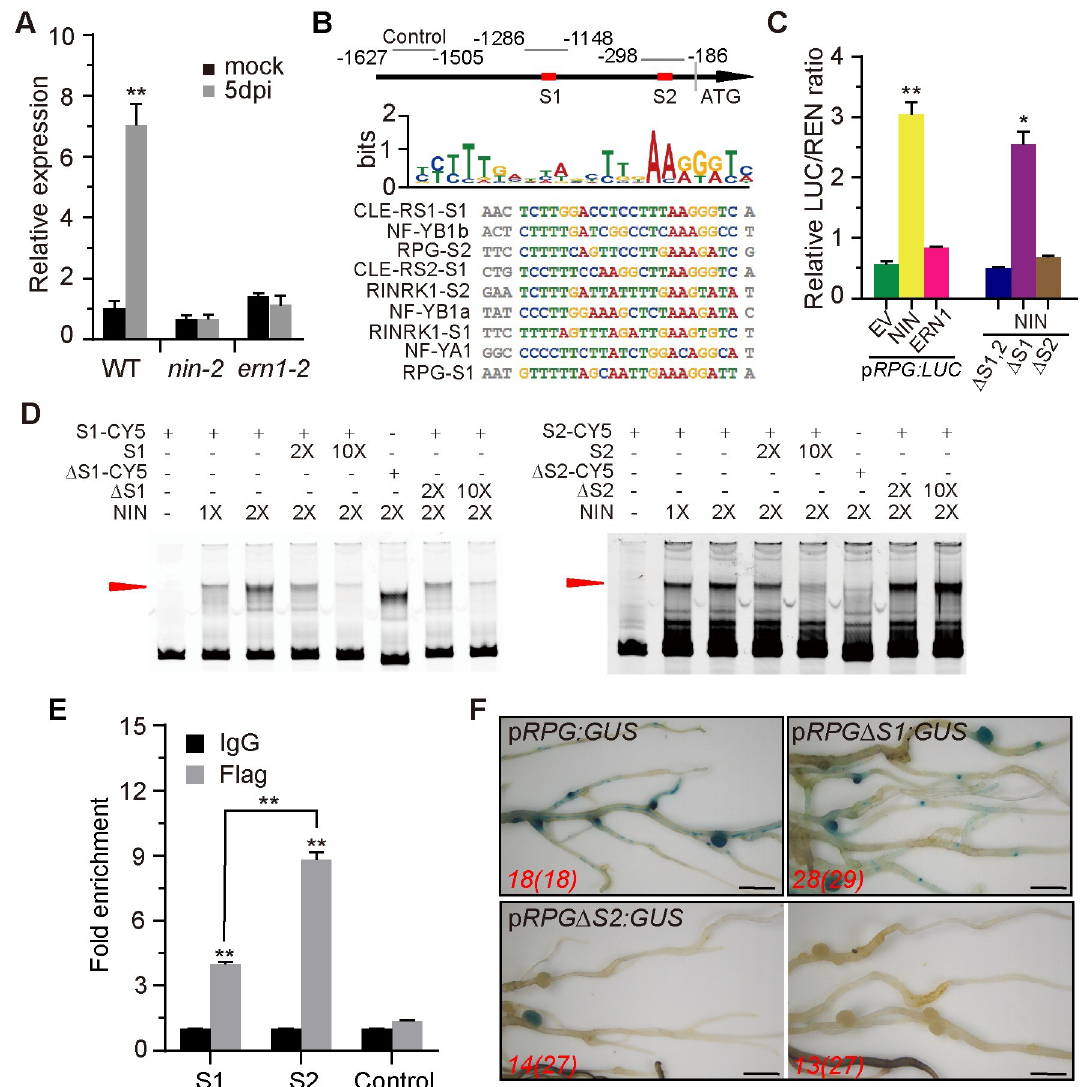
Fig 3. NIN induces RPG expression. (A) qRT-PCR analysis of RPG transcript levels in WT, nin-2 , or ern1-2 roots 5 days after inoculation with M . loti R7A. Expression is relative to that of mock-inoculated WT and normalized to L . japonicus Ubiquitin . Asterisks indicate significant differences between the mock-inoculated WT and the mutants (Students t -test). (B) Diagram of the RPG promoter region used for ChIP-qPCR analyses showing the locations of the putative NIN binding sites (NBS), S1 (-1157 bp) and S2 (-241 bp) upstream of the start codon. The sequence alignment shows the putative NBS of RPG aligned with previously identified NBS in L . japonicus CLE-RS1 , CLE-RS2 , NF-YB1 , NF-YA1 , and RINRK1 . Images were created with the MEME suite. The relation ship between binding site and ChIP-qPCR primer region is illustrated by the numbered nucleotides at the top of the alignment. (C) The luciferase activity of co-expressed ERN1 or NIN with p RPG :LUX in N . benthamiana leaves. Renilla Luciferase (REN) activity was used to normalize for the efficiency of transformation. Asterisks indicate significant differences between NIN/ERN expressing constructs and an empty vector (EV) by Students t -test. (D) Gel-shift assays of NIN binding to the promoter of RPG . For S1 and S2, a 2-fold and 10-fold excess of unlabeled DNA fragments were added as competitors for binding. (E) Chip-qPCR analysis of NIN binding to the RPG promoter in L . japonicus . pUb-NIN-Flag was expressed in L . japonicus hairy roots 5 days after rhizobium inoculation using either an anti-Flag antibody or IgG as a negative control. The fold enrichment of NIN binding was determined relative to IgG (control) IPs. One representative biological replicate out of three is shown. Asterisks indicate significant differences between the anti-FLAG antibody and IgG (Students t -test). (F) Assays of p RPG : GUS , p RPG Δ S1 : GUS ,p RPG Δ S2 : GUS expression in transformed L . japonicus roots. GUS activity was similar in p RPG : GUS and p RPG Δ S1 : GUS ,but showed reduced levels in p RPG Δ S2 : GUS .Scale bars: 5 mm (F).